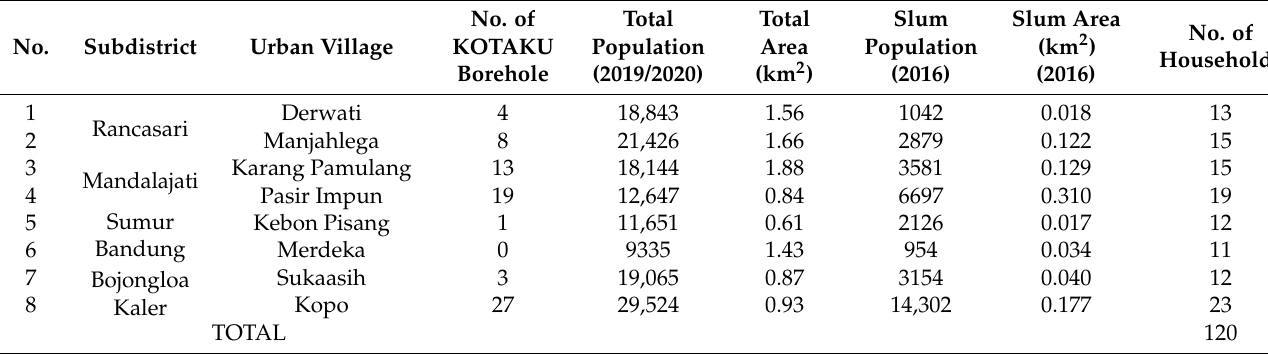
Table 1. Urban villages selected for household survey in Bandung